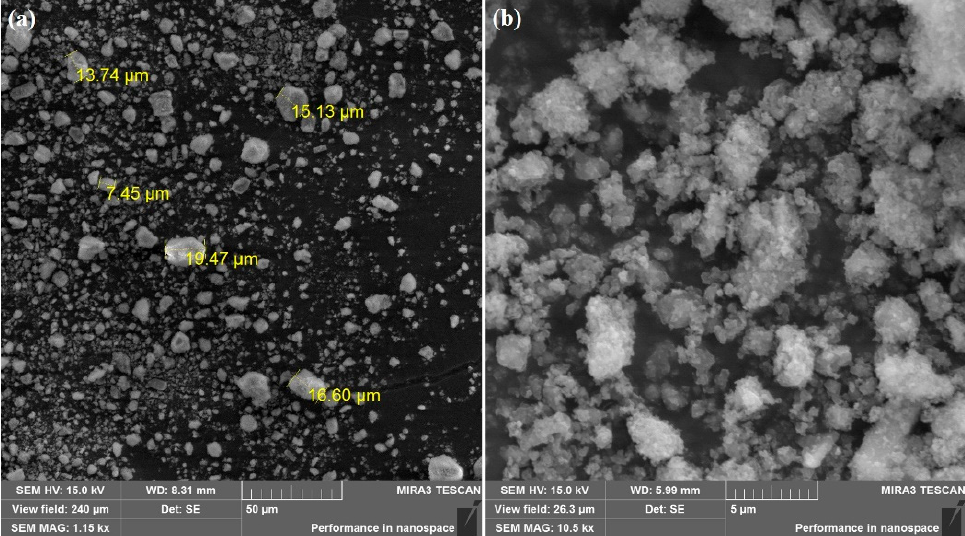
Figure 7. Morphology of HA. Morphology of HA ×1000 ( a ) and ×10,000 ( b ).